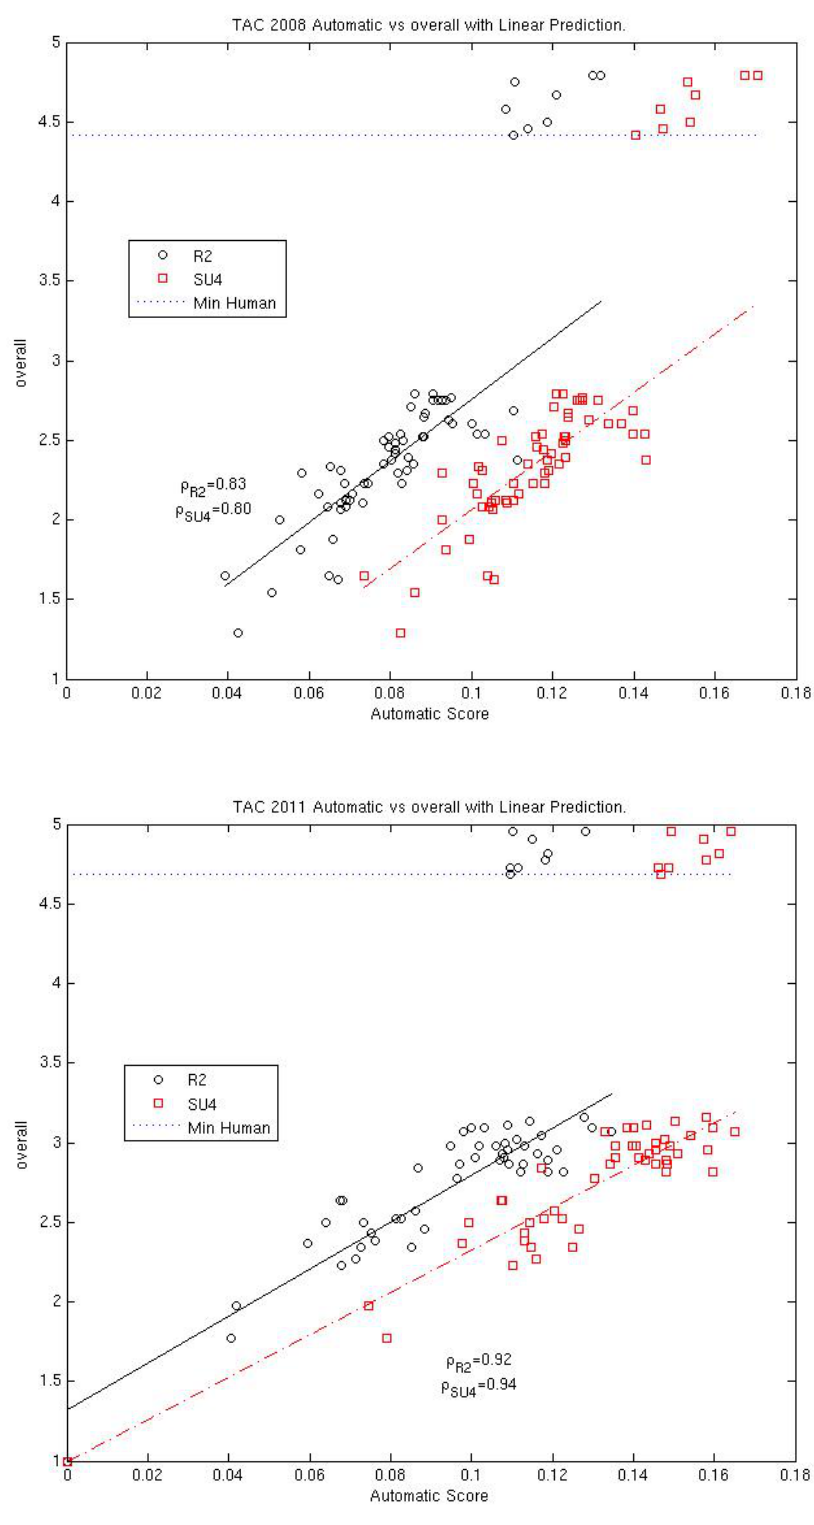
Figure 1. TAC 2008/2011 task